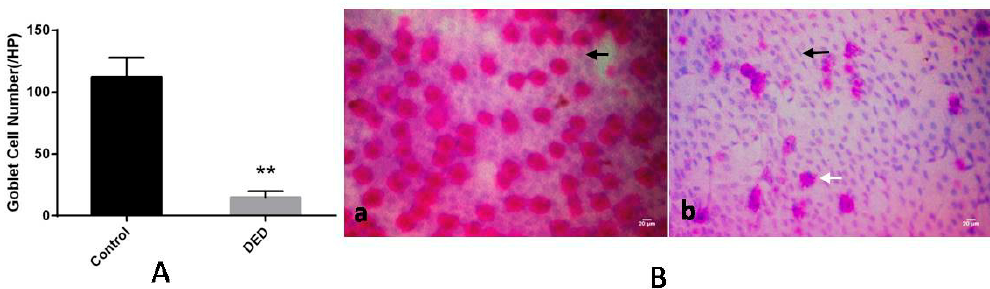
Figure 3. Conjunctival impression cytology (CIC) results for the eyes in the control and DED groups. ( A ) Goblet cell counts in the two groups. Compared with the control group, goblet cell counts were significantly decreased in the DED group; ( B ) CIC images for the two groups. The CIC grade was 0 in the control eyes ( a ), which featured normal-shaped conjunctival epithelial cells, large and round nuclei (black arrow), and plump goblet cells. The CIC grade was 2 in the DED eyes ( b ), which displayed squamous epithelial metaplasia, polygonal epithelial cells with smaller nuclei (black arrow), significantly decreased numbers of normal goblet cells, and irregularly shaped goblet cells (white arrow) (400×). ** p < 0.01. Scale bar = 20 μ m.